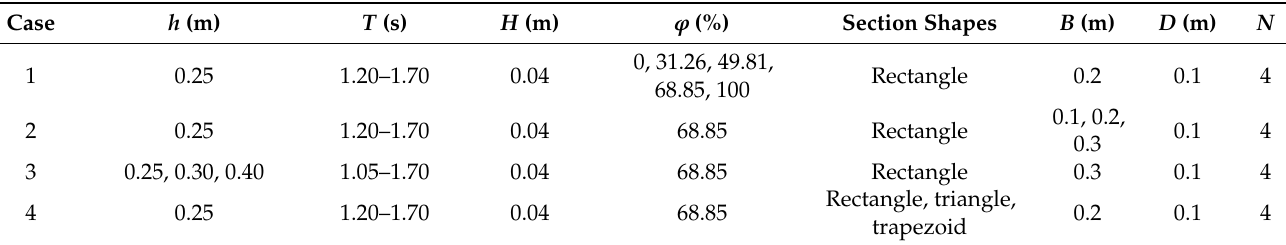
Table 3. Experimental cases and